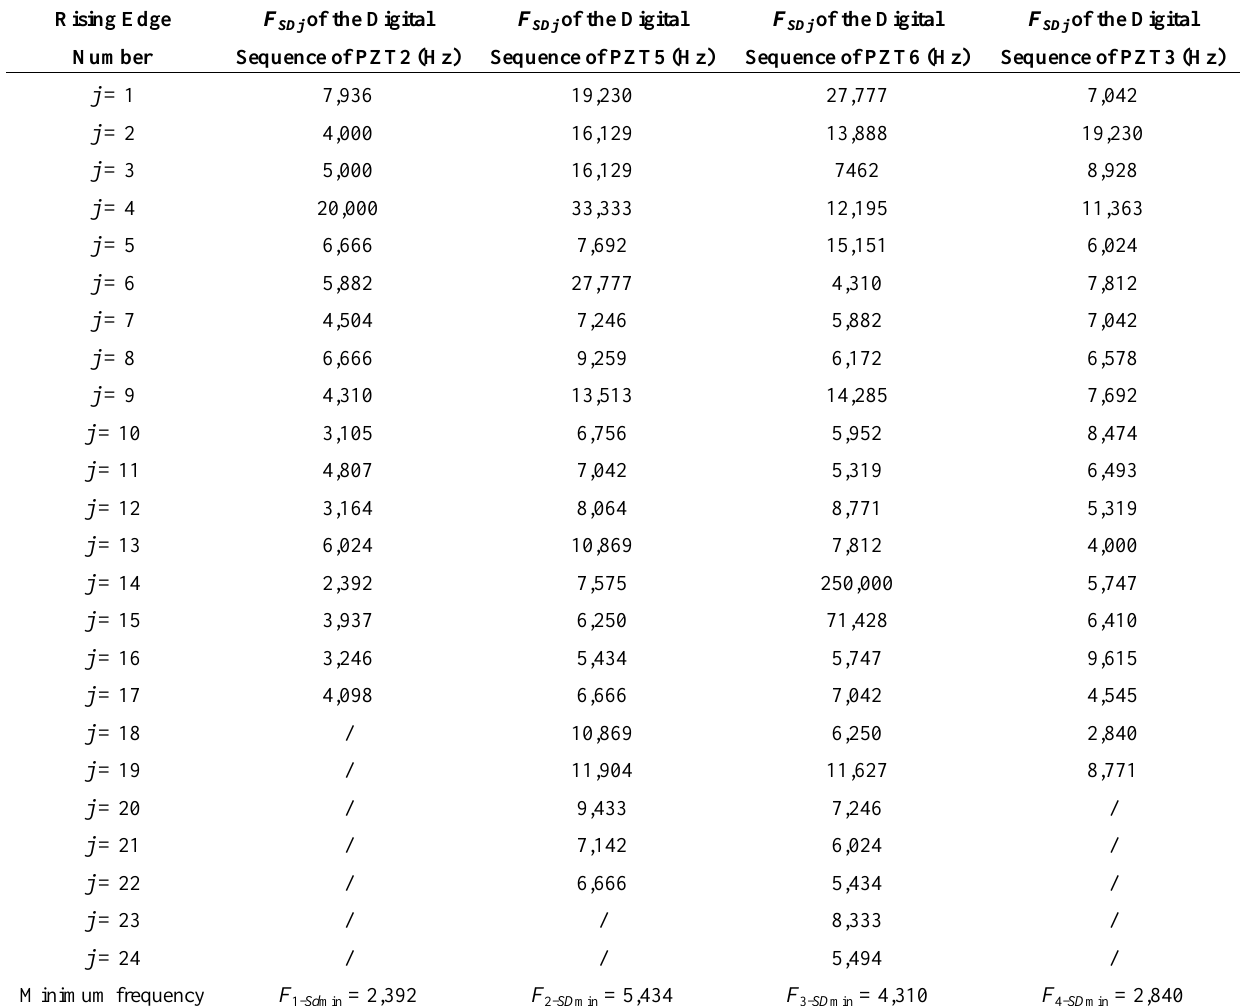
Table 2. The calculation results of the rising edge frequency of the digital sequences in Figure